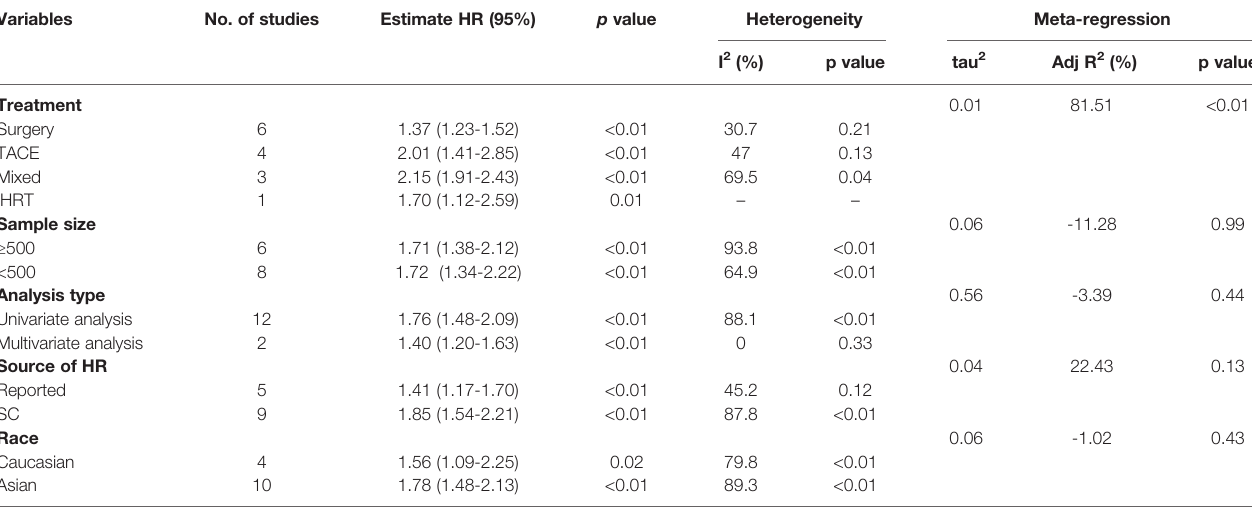
TABLE 2 | Subgroups analysis for the prognostic value of high PALBI grade in HCC patients .